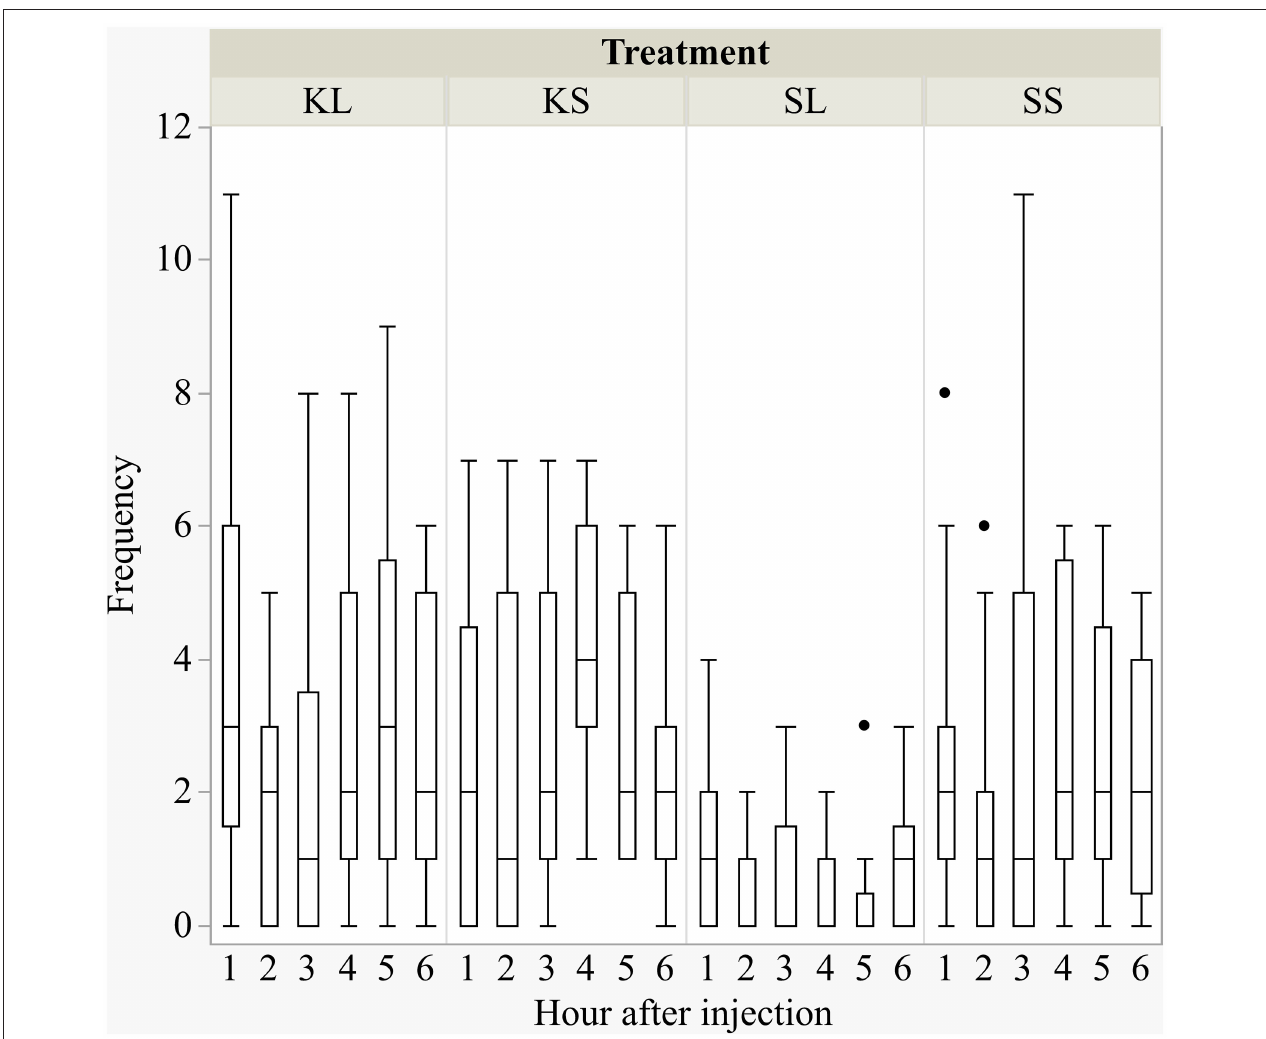
FIGURE 1 | Frequencies (per hour) of active behavior after injecting the pigs with ketoprofen–lipopolysaccharide (LPS), ketoprofen–saline, saline–LPS, and saline–saline. Round dots indicate outliers. N = 13 pigs per treatment.